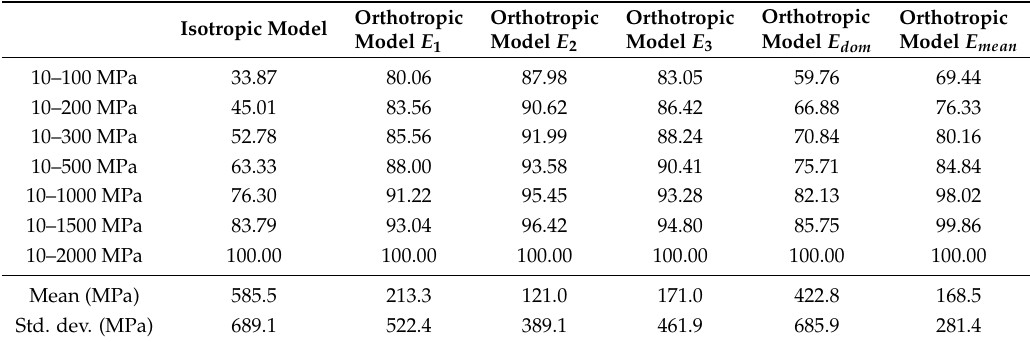
Figure 6. Trabecular elements’ radii distribution (mm) of the structural model - shown for ( a ) frontal, ( b ) lateral, and ( c ) medial views. Trabecular elements with a radius < 0.1 mm were excluded for clarity. Table 3. Cumulative distribution (%) of trabecular elastic moduli for the hybrid isotropic and hybrid orthotropic models.